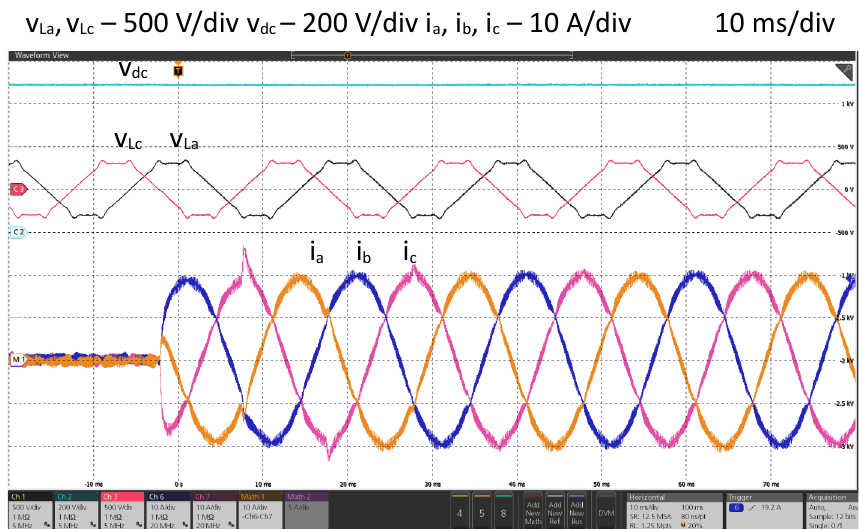
Figure 20. Experimental result for the step change i ∗ q for conventional plug-in repetitive control.